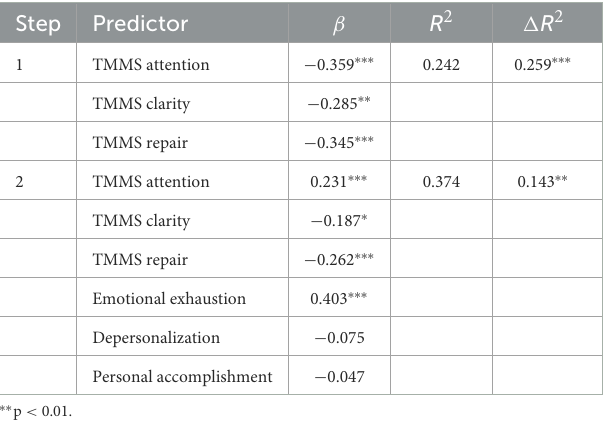
TABLE 3 Regression model results for the